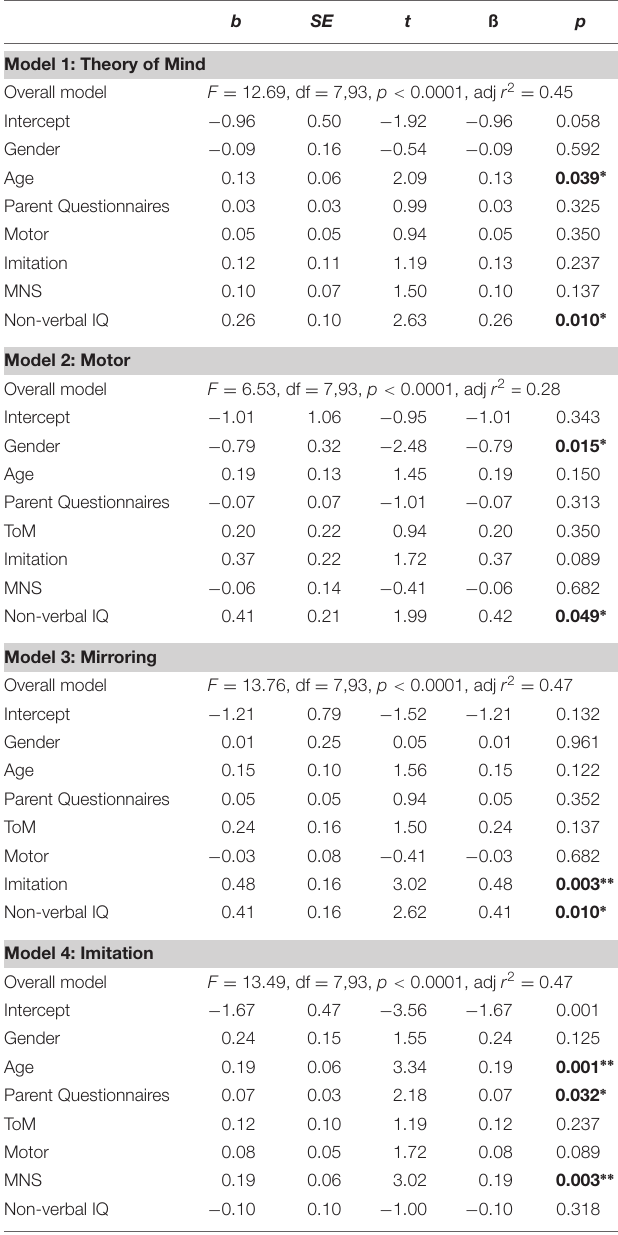
TABLE 2 | Results of the GLM analyses performed to test the relationship between performance on the cognitive tasks and parent report measures. b SE t ß